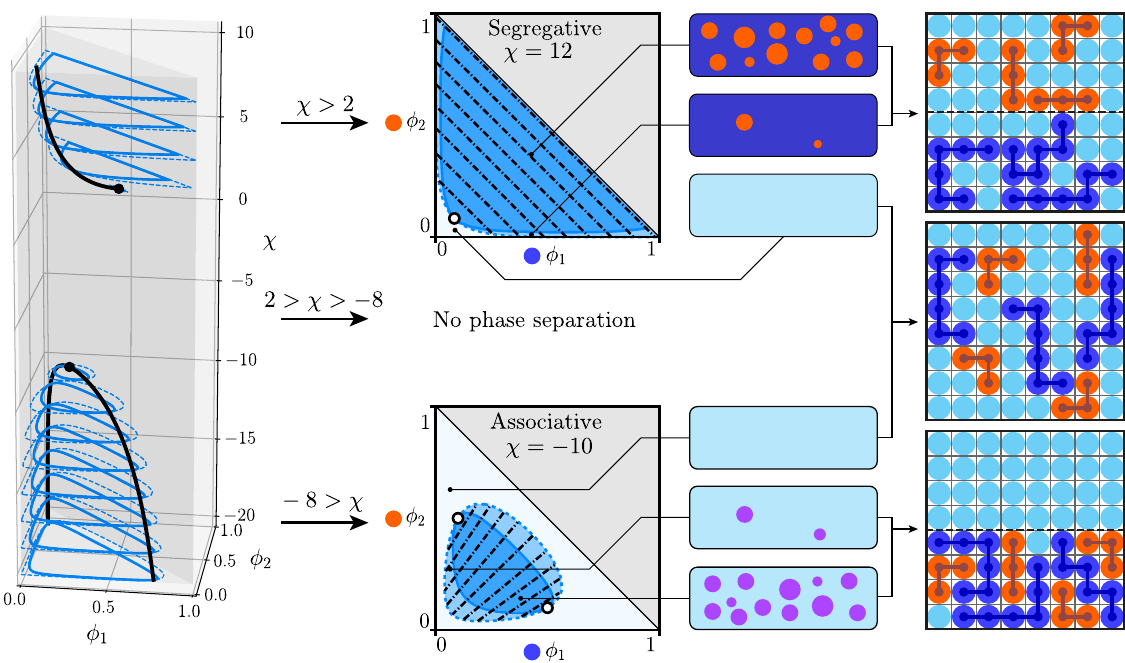
FIG. 1. Phase-space structure of a ternary system. Left column: critical points (black dots and black lines), spinodal boundaries (blue solid lines), and binodal boundaries (blue dashed lines) in the ð ϕ 1 ; ϕ 2 ; χ Þ space. No phase separation occurs in the 2 > χ > − 8 range. Central column: cross sections of phase space at χ ¼ 12 (top) and χ ¼ − 10 (bottom) corresponding to phase diagrams with critical points (hollow circles), spinodal (dark blue region), binodal (light blue region), and tie lines (black dashed lines) plotted. In the segregative case, the individual solutes demix into separate compartments, while in the associative case, they colocalize in condensates. Right column: lattice model illustration of the phase-separation